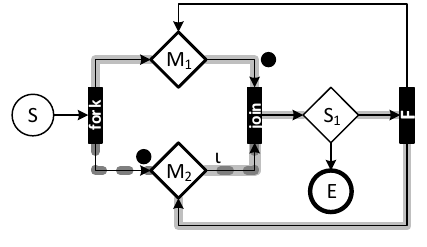
Figure 19. A sound workflow graph with the intersection ι of the fork node fork with two routes in grey and dashed lines